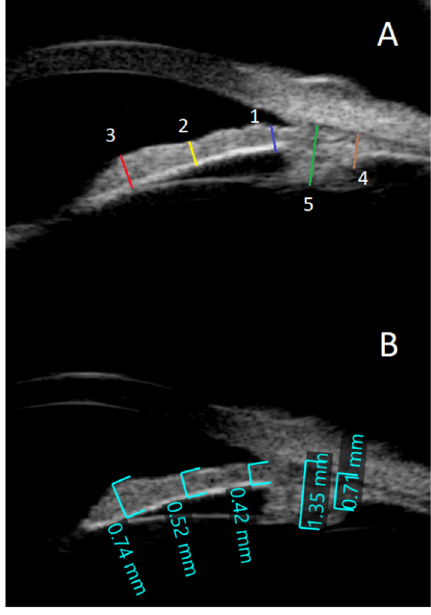
Figure 2. Ultrasound biomicroscopy (UBM): ( A ) This is an example of the UBM that shows the measured thicknesses for the iris and the ciliary body at different locations. The blue line (1) represents the iris thicknesses at 0.8 mm distance from the root of the iris. The yellow line (2) represents the iris thickness halfway down the radial length of the iris. The red line (3) represents the iris thickness at the juxtapupillary edge. The blue line (4) represents the thickness of the ciliary body, and the green line (5) represents the thickness of the ciliary body and the ciliary processes. ( B ) The iris thickness of one of the participants was 0.42 mm at a distance of 0.8 mm from the iris root, 0.52 mm in the mid of the radial length of the iris, and 0.7 mm at the juxtapupillary edge. The ciliary body was 0.72 mm thick, while the ciliary body with ciliary processes was 1.38 mm thick.